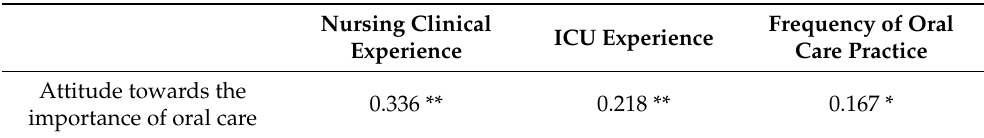
Table 6. Correlation between nursing clinical experience, ICU experience, frequency of oral care practice, and attitude towards the importance of oral